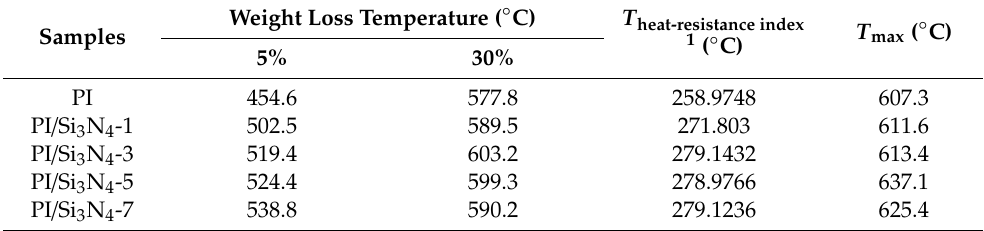
Figure 3. TGA analysis of PI and PI / Si 3 N 4 films. Table 1. Characteristic thermal data of PI and PI / Si 3 N 4 composites.